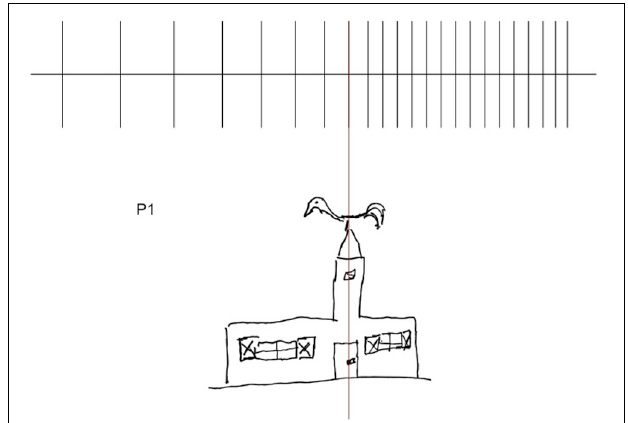
FIGURE 8 | Example of drawing from memory (P#1: